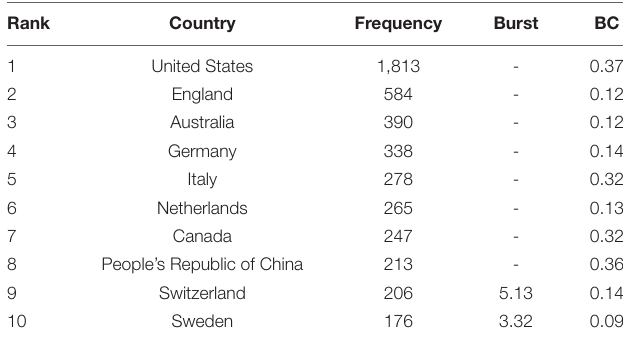
TABLE 1 | Top 10 influent countries of the psycho-cardiological disease and relevant